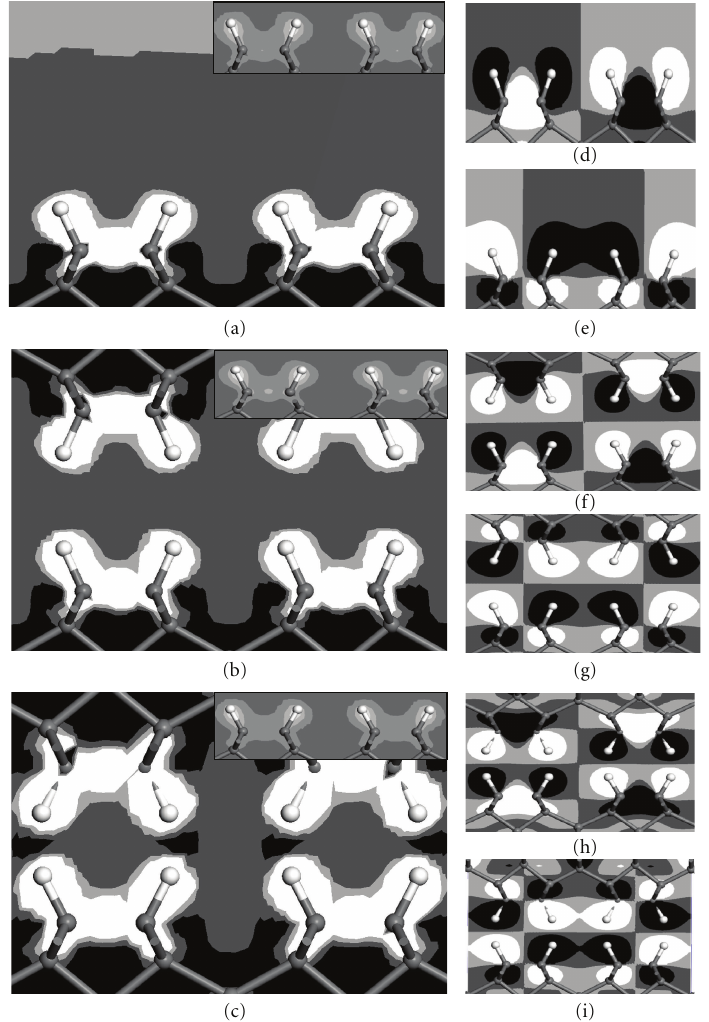
Figure 2: (a) Electron density difference map through the C–H bonds in the dimer parallel to the 𝑐 -axis of the C(100)2x1 slab, black = ( − 10%) to ( − 5%), dark gray = ( − 5%) to (0%) density loss, light gray = (0%) to (5%), and white = (5%) to (10%) density gain, inset is the same map with − 100% to +100% in four equal steps from density loss to gain as in part (a) and shows little density build up; however, some +25% ± 25% density difference light gray areas are slightly visible between the carbon atoms in the dimer. (b) Electron density map through the C–H bonds on the upper and lower slabs dimers when at a separation with a net cohesive stabilization, electron density difference color scheme is the same as part (a); inset is map through the lower slab dimer C–H with color scheme as in inset to part (a), showing more electron density build up between the C–C atoms in the dimer than (a). (c) Electron density map through the C–H bonds on the upper and lower slab dimers at a separation having a net repulsive interaction, electron density difference color scheme is the same as part (a) black patches between opposing dimer hydrogen atoms, has negative electron density difference, and is assigned to Pauli repulsion at this separation; inset is map through the lower slab dimer C–H with color scheme as in inset to part (a), showing no electron density build up between the C–C atoms in the dimer. (d) Map of the highest occupied orbital centered on the dimer on the C(100)2x1-H surface through the C–H bonds and parallel to the 𝑐 -axis, darker colors are negative phase and lighter colors the positive; steps plotted are from − 0.02 to − 0.01, − 0.01 to 0, 0 to 0.01, and 0.01 to 0.02 electron/˚A 3 ; orbital is dominantly due to the 𝜎 C–C bond with highest values between the carbon atoms. (e) Map of the highest occupied orbital centered on the C–H on the C(100)2x1-H surface through the C–H bonds, color scheme is the same as in part (d); orbital is dominantly due to the 𝜎 C–H bond with some overlap between neighboring hydrogen atoms on different dimers. (f) Similar map of the highest occupied orbital centered on the dimers on the C(100)2x1-H surface-to-surface interaction at a separation having a net cohesive stabilization, orbital is dominantly due to the 𝜎 C–C bond that has changed little from part (d). (g) Similar map of the highest occupied orbital centered on the C–H when slabs have net cohesive stabilization; orbital is dominantly due to the 𝜎 C–H bond with no overlap between neighboring hydrogen atoms on different dimers. (h) Similar map of the highest occupied orbital centered on the dimer when the slabs are experiencing a repulsive interaction; orbital is dominantly due to the 𝜎 C–C bond now having high orbital values moved from between the carbon atoms to beneath and outside of the C–C bond. (i) Similar map of the highest occupied orbital centered on the C–H when the interacting slabs experience a net repulsion; orbital is dominantly due to the 𝜎 C–H bond now with some overlap between neighboring hydrogen atoms on different